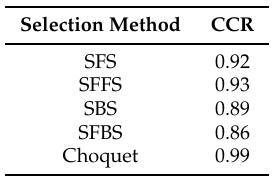
Table 4. Correct classification rates correct recognition rate (CCR) when applying sequential forward selection (SFS), sequential floating forward selection (SFFS), sequential backward selection (SBS), sequential floating backward selection (SFBS) and Choquet integral based